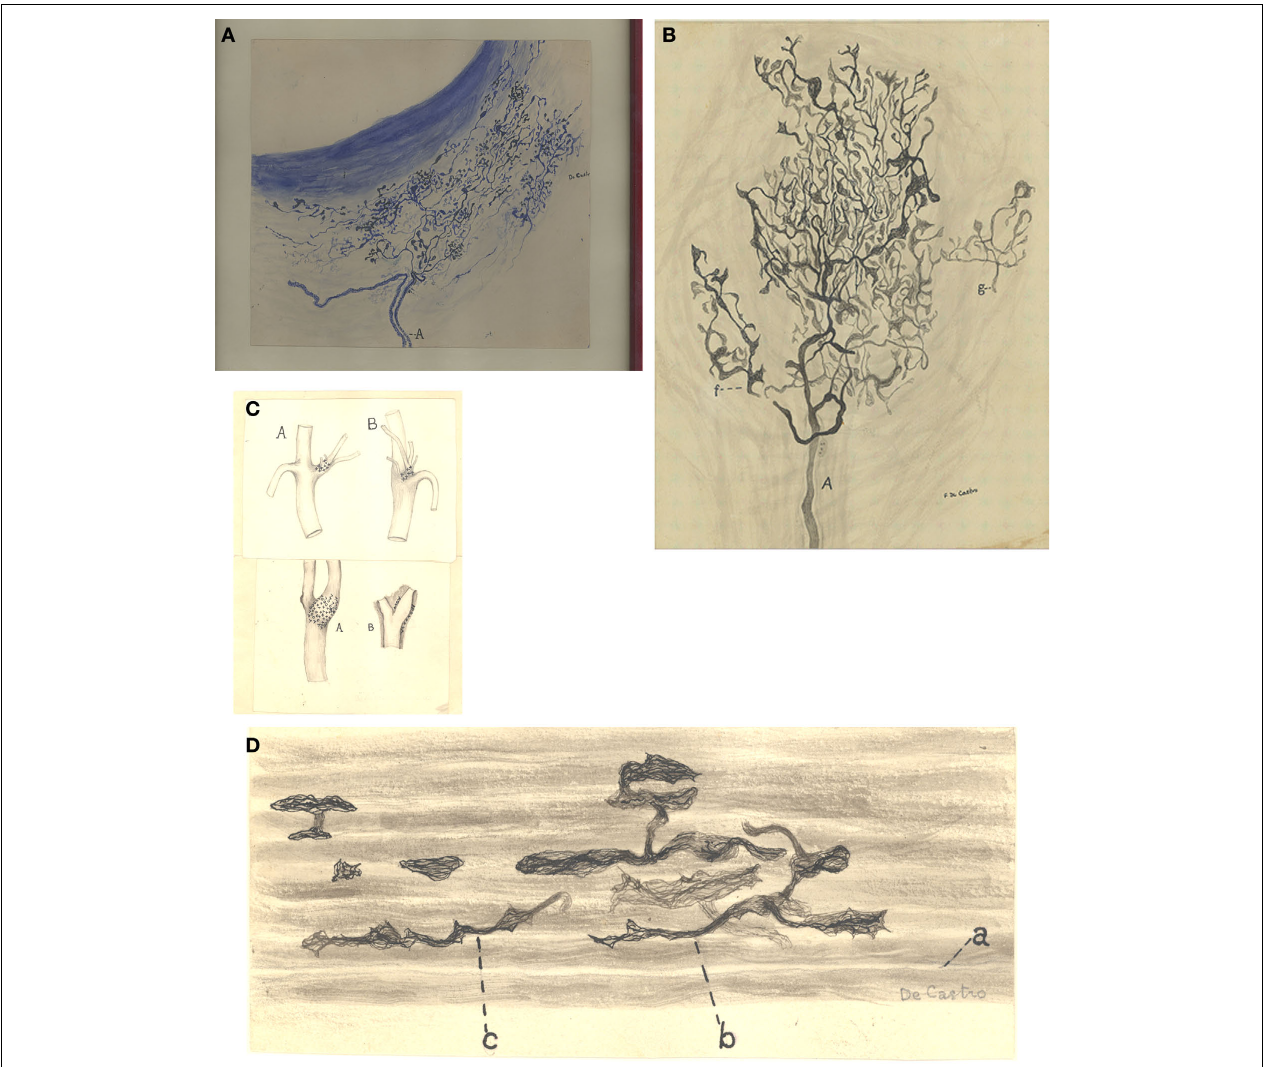
FIGURE 3 | De Castro’s detailed description of the baroreceptors in the carotid sinus (1928). Fernando De Castro’s original drawings from his second publication on the innervation of the carotid region (De Castro, 1928). (A) Illustration of a type I (diffuse) baroreceptor close to the adventitia of the artery from a young human, stained with methylene blue. (B) Detailed illustration of a type II (circumscribed) baroreceptor of the human carotid sinus, stained by silver impregnation. The myelin trunk is marked by A .